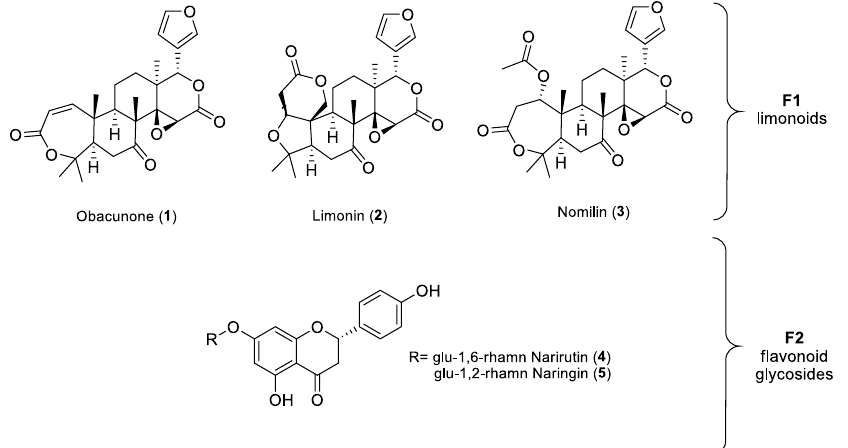
Figure 2. Structures of purified limonoids and flavonoid glycosides. Fraction F1 : obacunone ( 1 ), limonin ( 2 ) and nomilin ( 3 ); fraction F2 : narirutin ( 4 ) naringin ( 5